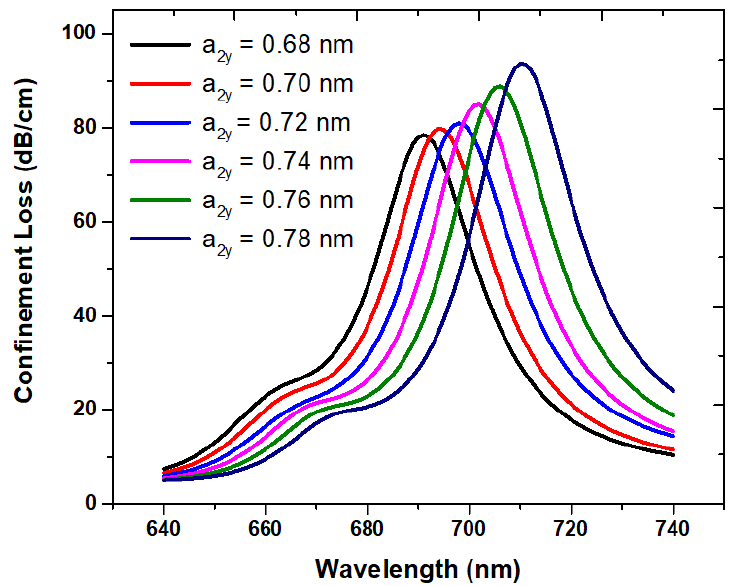
Figure 6. Confinement loss spectra of the core-guided mode for a 2y = (0.68, 0.70, 0.72, 0.74, 0.76, 0.78) µm.